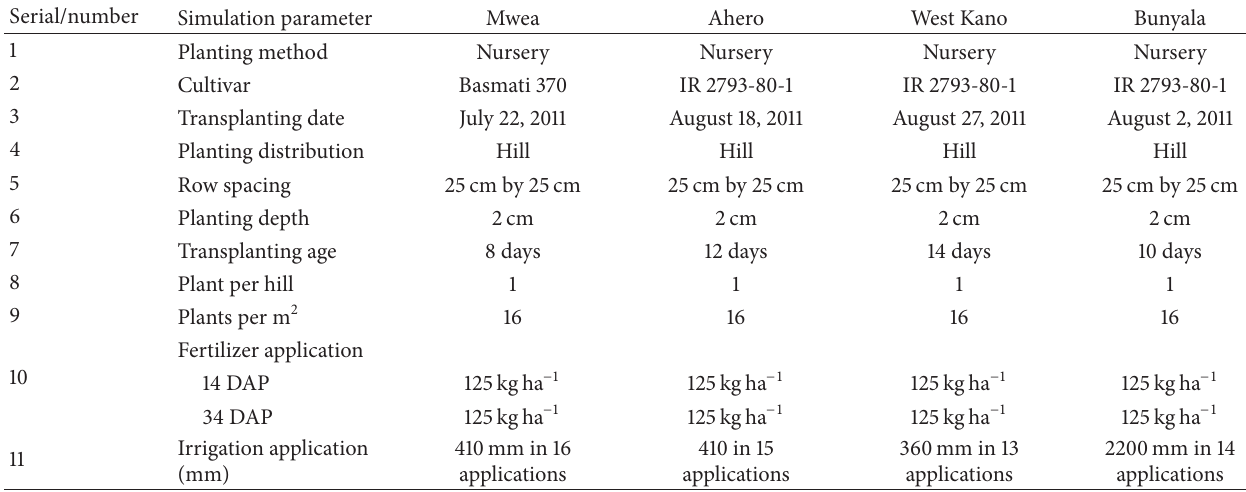
Table 1: Crop management data used in the